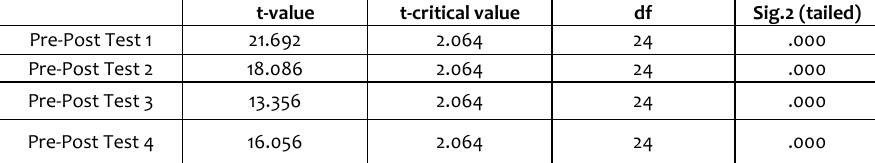
Table 2: Differences in the Respondents’Pre-test and Post-test Performance